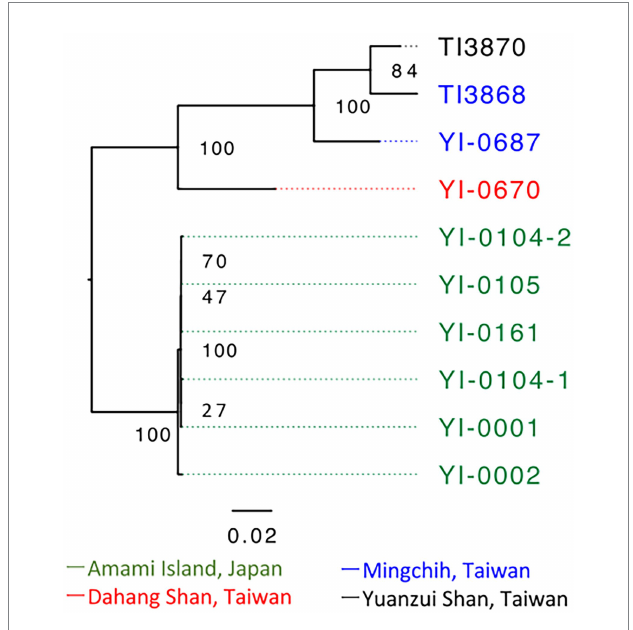
FIGURE 2 Phylogenetic analysis based on 5,887 SNPs of V. emarginatum samples using RAxML-NG and visualized by FigTree version 1.4.4. The numbers at the nodes indicate bootstrap support. Sample numbers are color- coded by population; green is for Amami Island, blue is for Mingchih, red is for Dahang Shan and black is for Yuanzui Shan.